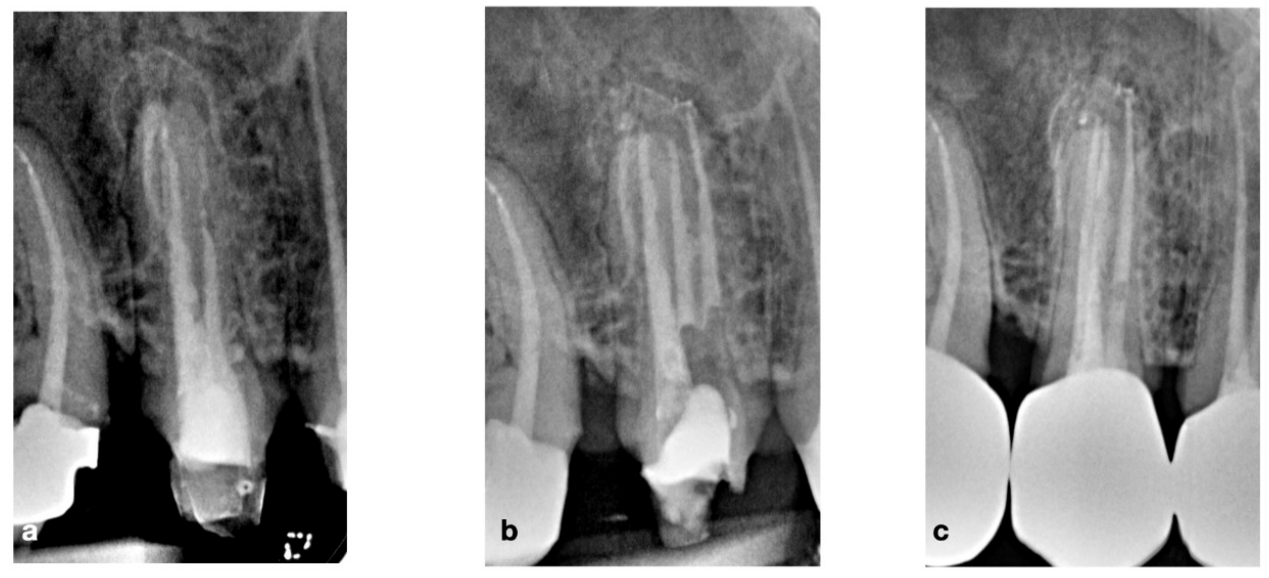
Figure 6. ( a ) Pre-operative view of the premolar, ( b ) post-operative X-ray of the four canals filled Figure 6. ( a ) Pre ‐ operative view of the premolar, ( b ) post ‐ operative X ‐ ray of the four canals filled with gutta-percha, ( c ) 1-year with gutta ‐ percha, ( c ) 1 ‐ year follow ‐ up.